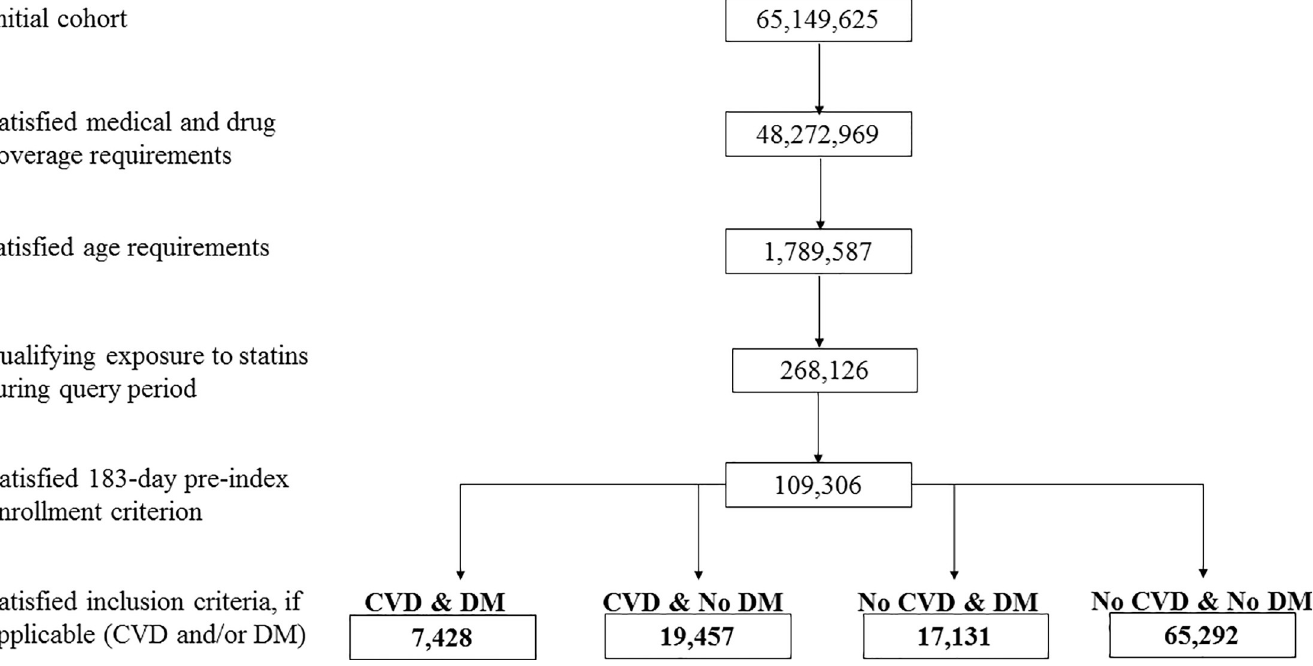
Fig 1. Cohort attrition for CVD & DM, CVD & No DM, No CVD & DM, and No CVD & No DM cohorts, all duration of statin use among initiators aged > 75 years, NIH Collaboratory Distributed Research Network, January 1, 2008- March 31, 2018. Abbreviations: CVD = cardiovascular disease; DM = diabetes mellitus.